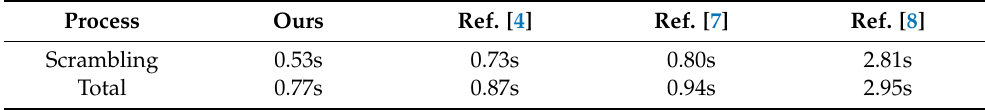
Table 8. Encryption time test